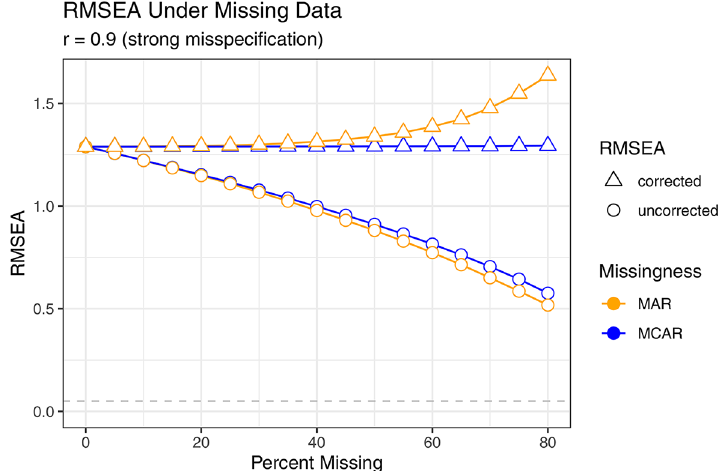
Simulation Results for Data Generated With a Covariance of